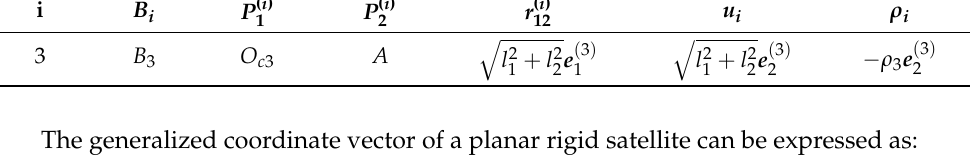
Figure 5. NCF-based Planar Rigid Body Satellite. Table 1. Selection of generalized coordinates for rigid body satellites.